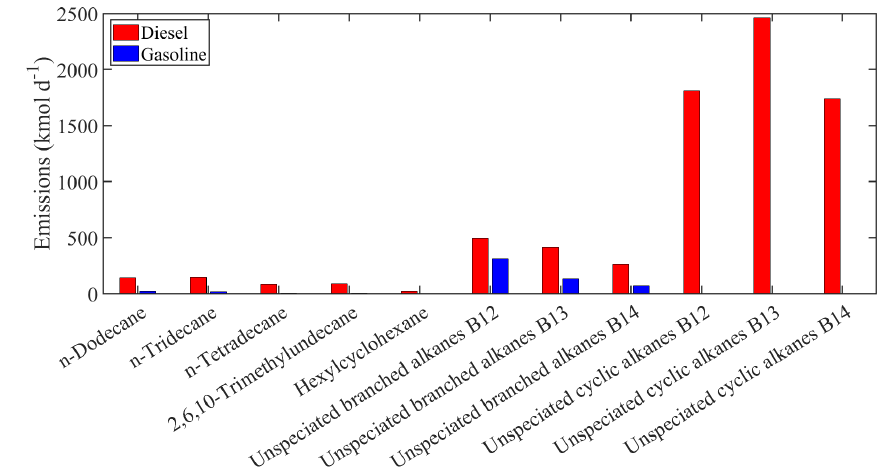
Figure 2. Estimated total gasoline and diesel emissions of the new individual compounds lumped into ALK6 for